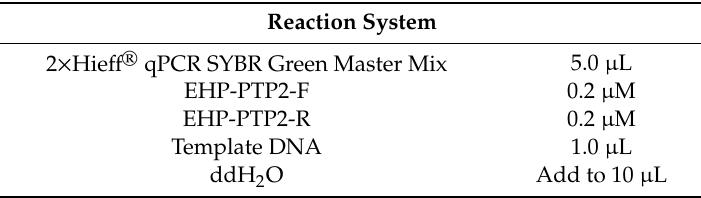
Table 2. The reaction system of PTP2-qPCR (10 µ